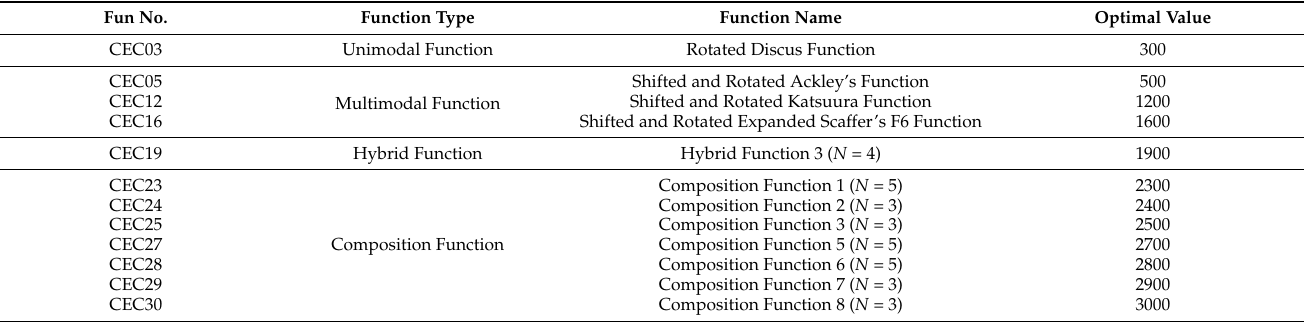
Table 6. Part of CEC2014 test function.